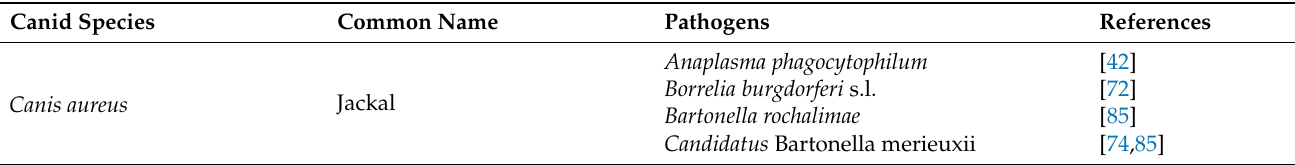
Table 1. Molecular or cultural detection of bacterial arthropod-borne pathogens in wild canids in relation to the animal